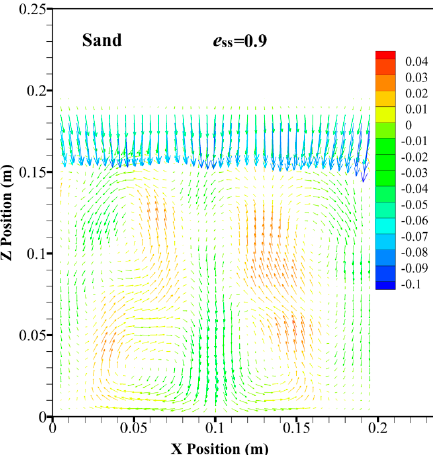
Figure 6. Time-averaged particle velocity distribution of the jetsam for e ss = 0.9 (the color legend represents the axial velocity of the particles).